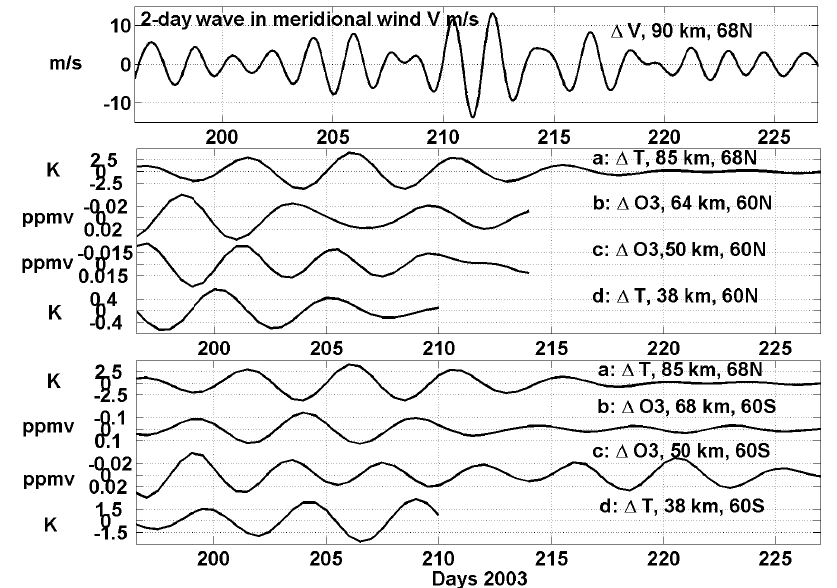
Fig. 5. Wave perturbations for 15 July–13 August 2003: Upper panel: 2-day wave from ground-based radar measurements of meridional wind (m/s) over Esrange (67 ◦ 56 0 N, 21 ◦ 04 0 E), at 90km. Middle panel: 5-day perturbations: (a) from ground-based radar measurements of temperature over Esrange (67 ◦ 56 0 N, 21 ◦ 04 0 E), at 85km. (b–d) from Odin retrievals at latitude=60 ◦ N, longitude=21 ◦ E: for ozone (ppmv) at 64km (b) and at 50km (c), for temperature (K) at 38km (d), (Note: reverse scale for ozone). Lower panel: 5-day perturbations: (a) same as on the middle panel. (b–d) from Odin retrievals at latitude=60 ◦ S, longitude=21 ◦ E: for ozone (ppmv) at 68km (b) and at 50km (c), for temperature (K) at 38km (d), (Note: reverse scale for